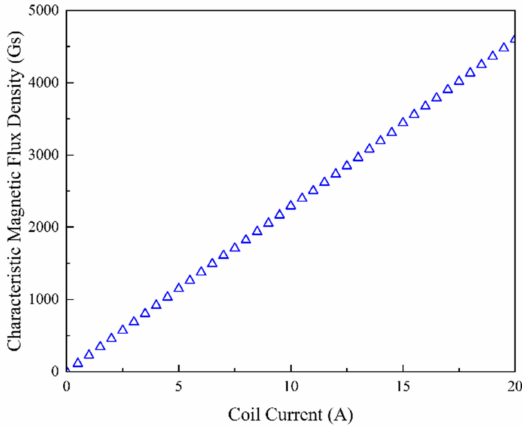
Figure 5. The linear relationship between the simulated characteristic magnetic flux density and coil